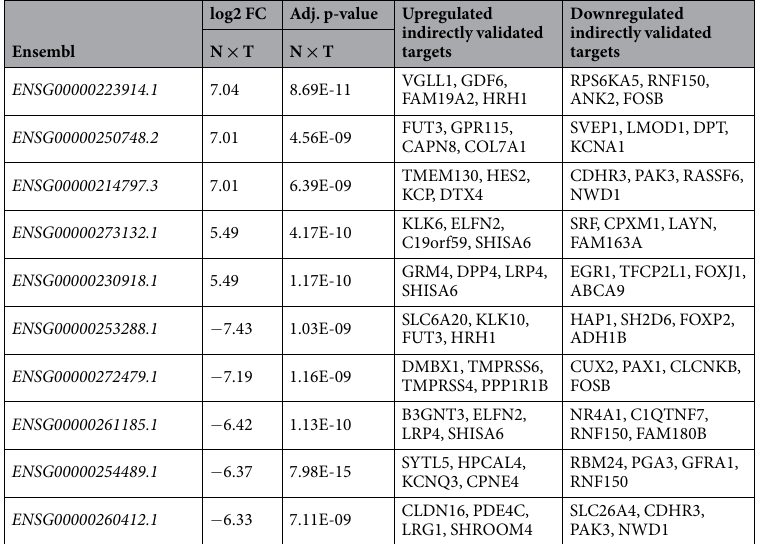
Table 2. Top 5 upregulated and 5 downregulated DE lncRNAs between paired Normal × Tumor with examples of indirectly validated targets.